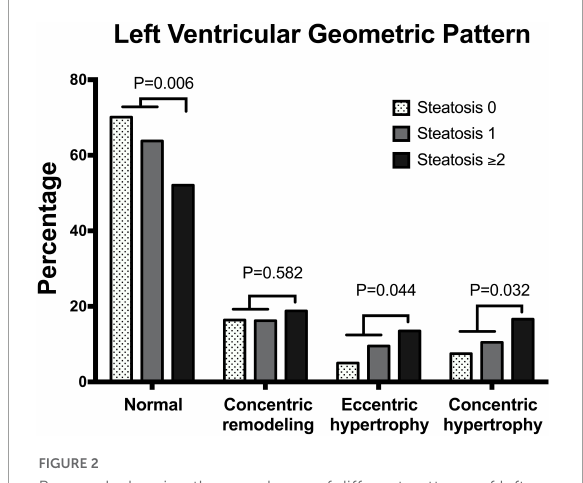
FIGURE2 Bar graph showing the prevalence of different patterns of left ventricular geometry in patients with essential hypertension according to the number of liver steatosis scores (none, 1, ≥ 2).